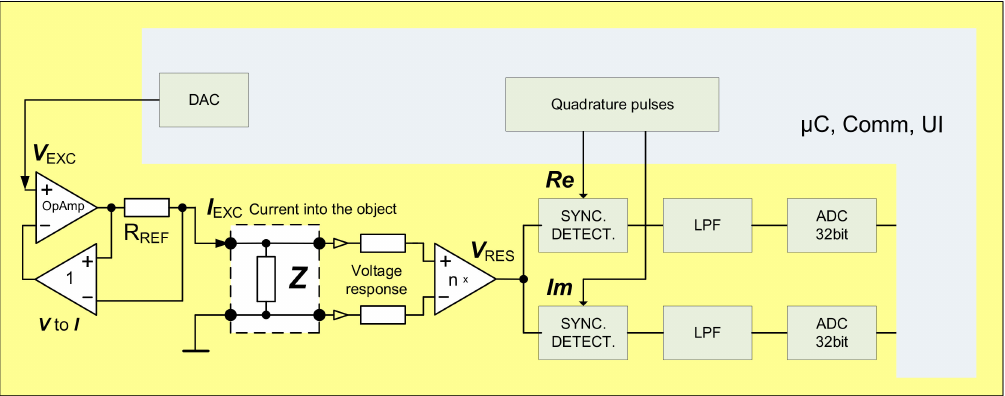
Figure 6. Main components of the “brute force device” using high resolution ADCs for detection of the